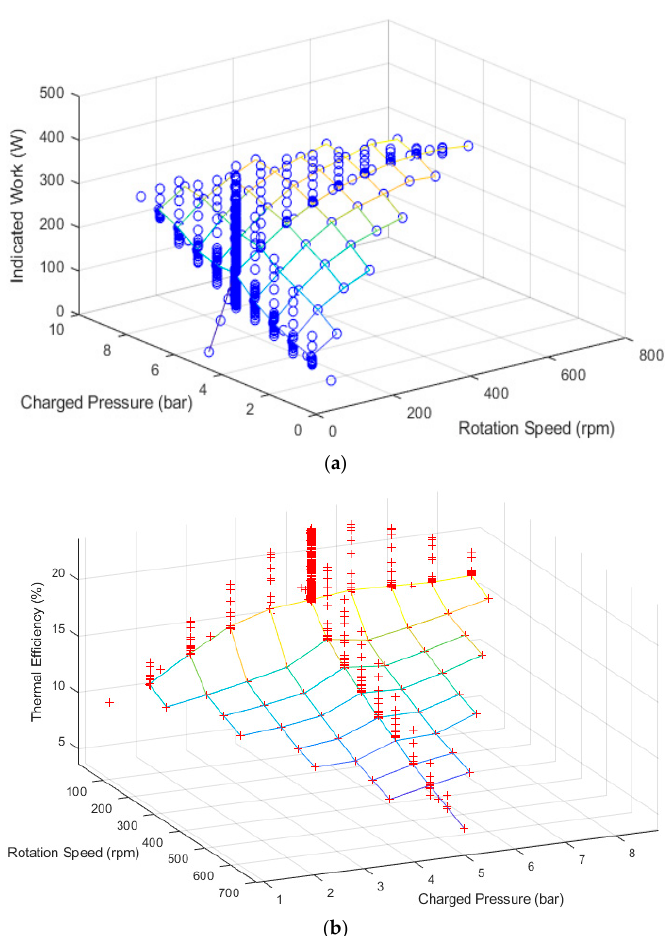
Figure 5. Data distribution after interpolation. ( a ) Indicated power as a function of charged pressure and rotation speed. ( b ) Thermal efficiency as a function of charged pressure and rotation speed.